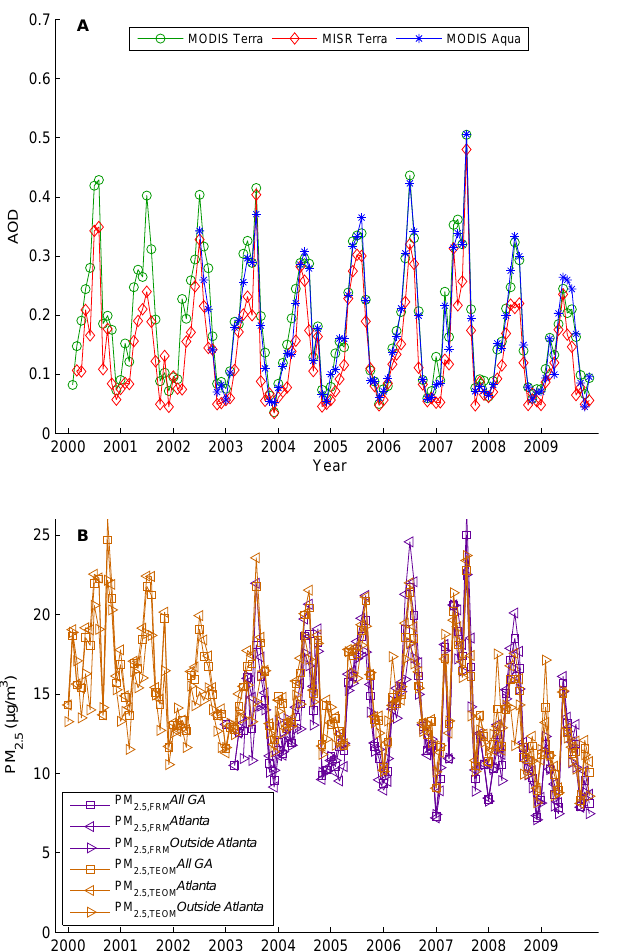
for PM 2 . 5 , TEOM All GA and PM 2 . 5 , TEOM Atlanta are not statis- tically significant, yet PM 2 . 5 , TEOM Outside Atlanta is